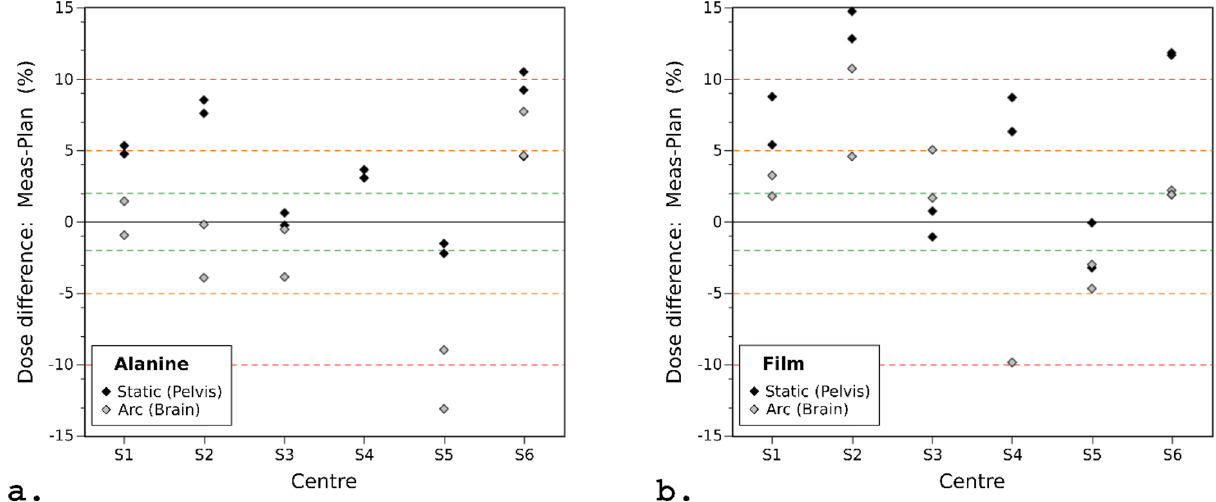
Figure 5. Percentage difference between planned and measured doses on the SARRP irradiators for the ( a ) alanine and ( b ) film measurements. A positive value indicates the measured dose was greater than the planned dose. The dashed green, orange and red lines indicate 2%, 5% and 10% differences from the prescribed dose,